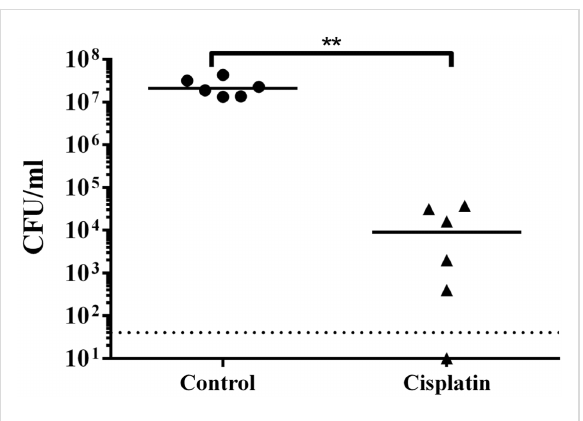
Figure 7: Cisplatin treatment attenuates P. aeruginosa infections. CFU mL − 1 of PAO1 obtained from corneas with and without cisplatin treatment. Dotted horizontal lines represent limit of detection. The mean and s.d. from six experiments were shown for in vivo biofilms. Student’s t-test was performed for testing differences between groups. * P <